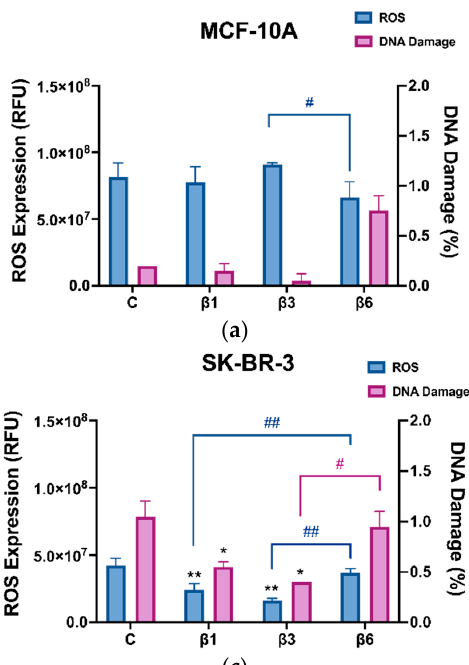
Figure 3. Percentage of ferroptotic cells after treatment with β 1-conglutin (2.5 ng/µL), β 3-conglutin (5 ng/µL), or β 6-conglutin (10 ng/µL) for 24 h in ( a ) MCF-7, ( b ) SK-BR-3, and ( c ) MDA-MB-321. After 24 h of ( a ) β 1, ( b ) β 3, and ( c ) β 6-conglutin treatment +/- Ferrostatin 1 (1 µM) cells were trypsinized, washed, and incubated for 15 min with both AnnexinV-FITC and Propidium Iodide from the IP-Annexin V kit (BD Biosciences, UK). Samples were immediately analyzed using the BD FACS Aria IIIu Flow Cytometer (Becton Dickinson, BD Bioscience). ** p < 0.01 vs. non-treated cells, and # p < 0.05, ## p < 0.01, and ### p < 0.001 vs. other treatments. Treatment of all BC cell lines for 24 h induces an inhibition of ROS levels accompanied by an inhibition of DNA damage. β 1 and β 3-conlgutins are the most effective treatments for both MCF-7 and SK-BR-3, but β 6 has no significant effect on SK-BR-3. Interestingly, no significant changes in ROS levels or DNA damage were found in the healthy cells, MCF-10A. Representative dot plots for DNA damage detection by flow cytometry are shown in Supplementary Figure S5 of the supplementary data.